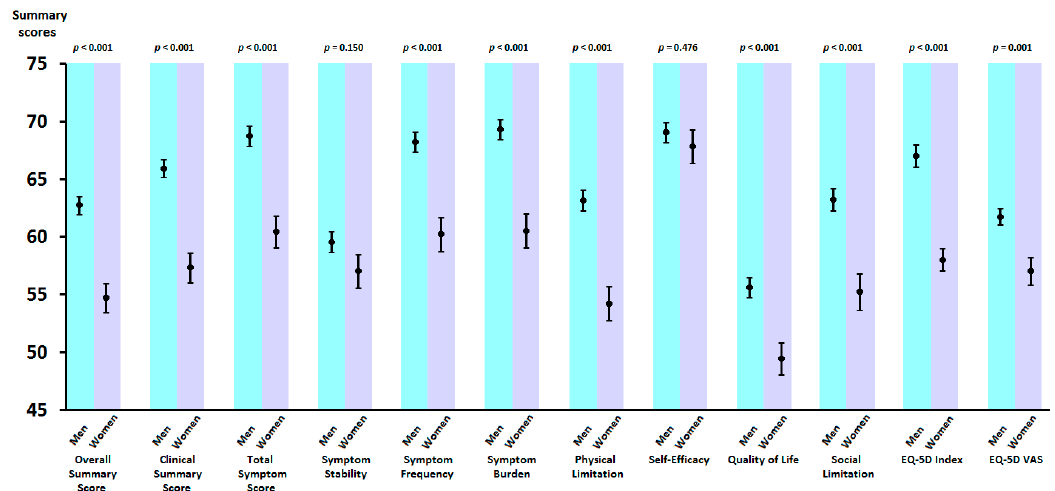
Figure 2. Adjusted scores (marginal means ± standard error of the mean) of the summary scores and sub-domains of the KCCQ and EQ-5D according to gender using multivariate general linear models. Adjustment variables were: age, body mass index, heart rate, NYHA functional class, LVEF, co-morbidity burden, HF etiology, presence of hypertension, diabetes mellitus, chronic kidney disease, atrial fibrillation, hemoglobin, admission service, recent admission for HF (last 6 months), and time since HF diagnosis.